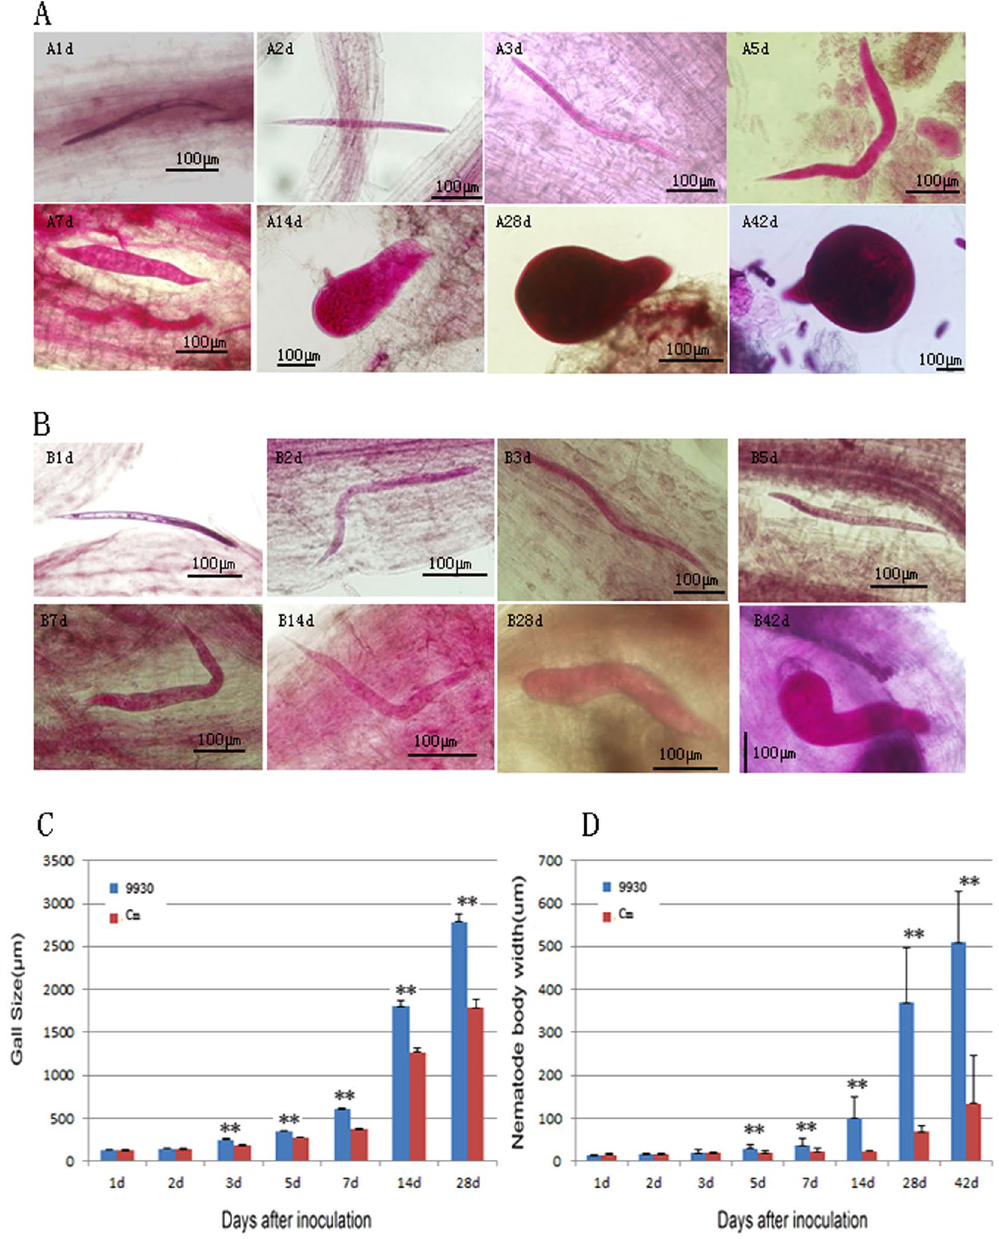
Figure 1. The development comparison of Mi between 9930 and Cm . ( A ) Represents 9930 and B represents Cm ; The data followed ( A or B ) represents the days after inoculation; ( C ) comparison of gall size between 9930 and Cm; ( D ). comparison of nematode body width between 9930 and Cm . The ** Indicate significant difference at 0.01 level of